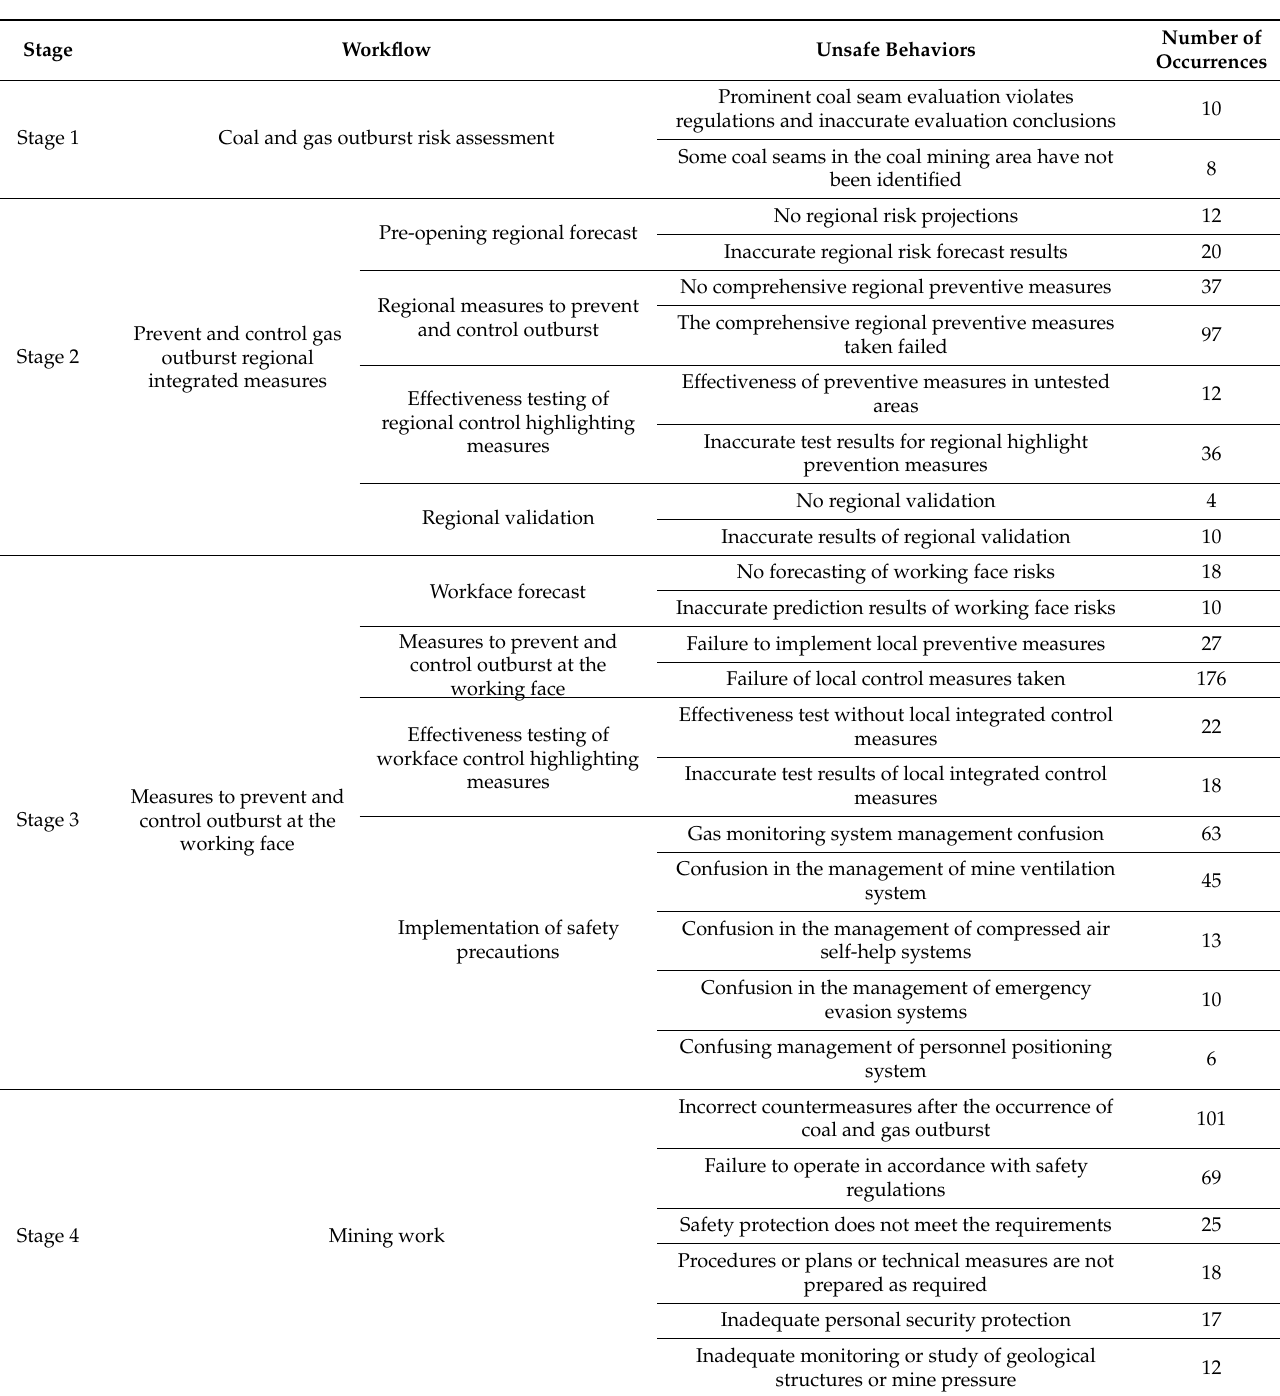
Table 3. Summary of unsafe behaviors for gas outburst